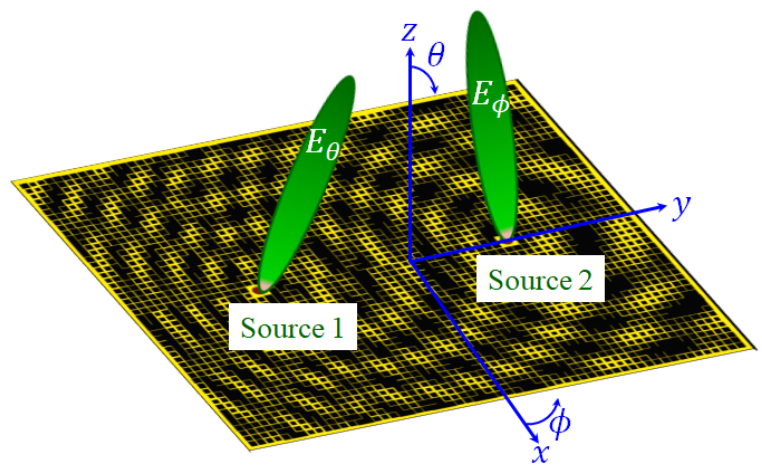
Figure 12. A holographic metasurface, fed by two sources, that forms a pencil beam with three reconfigurable polarization states: vertical, horizontal, and circular polarizations [23].